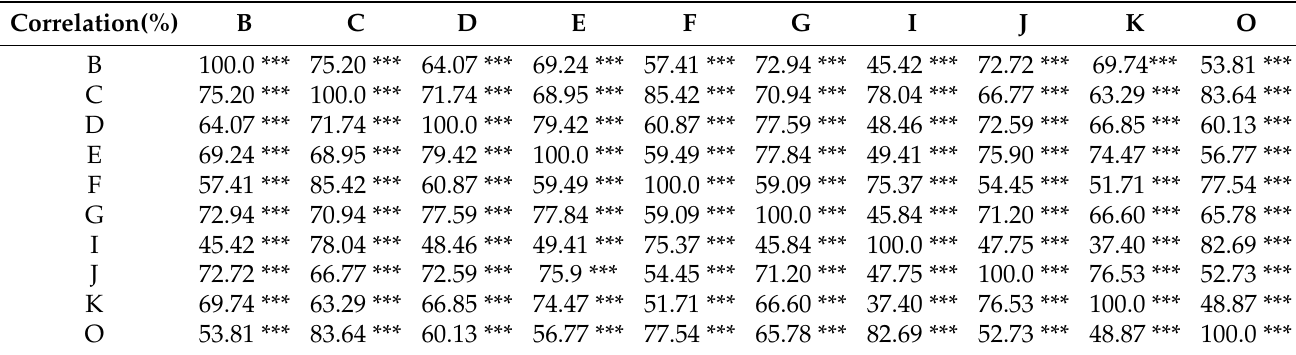
Table 9. Correlation analysis of sector